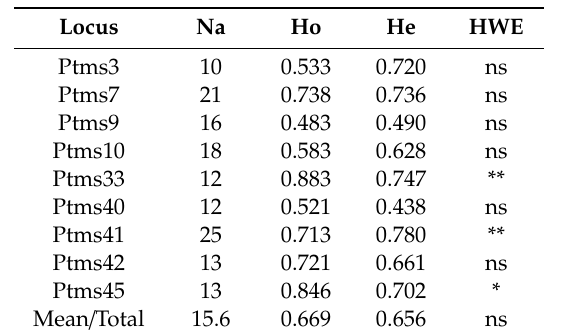
Table 2. Genetic characteristics of nine microsatellite loci in six Pistacia chinensis populations containing a total of 180 individuals.